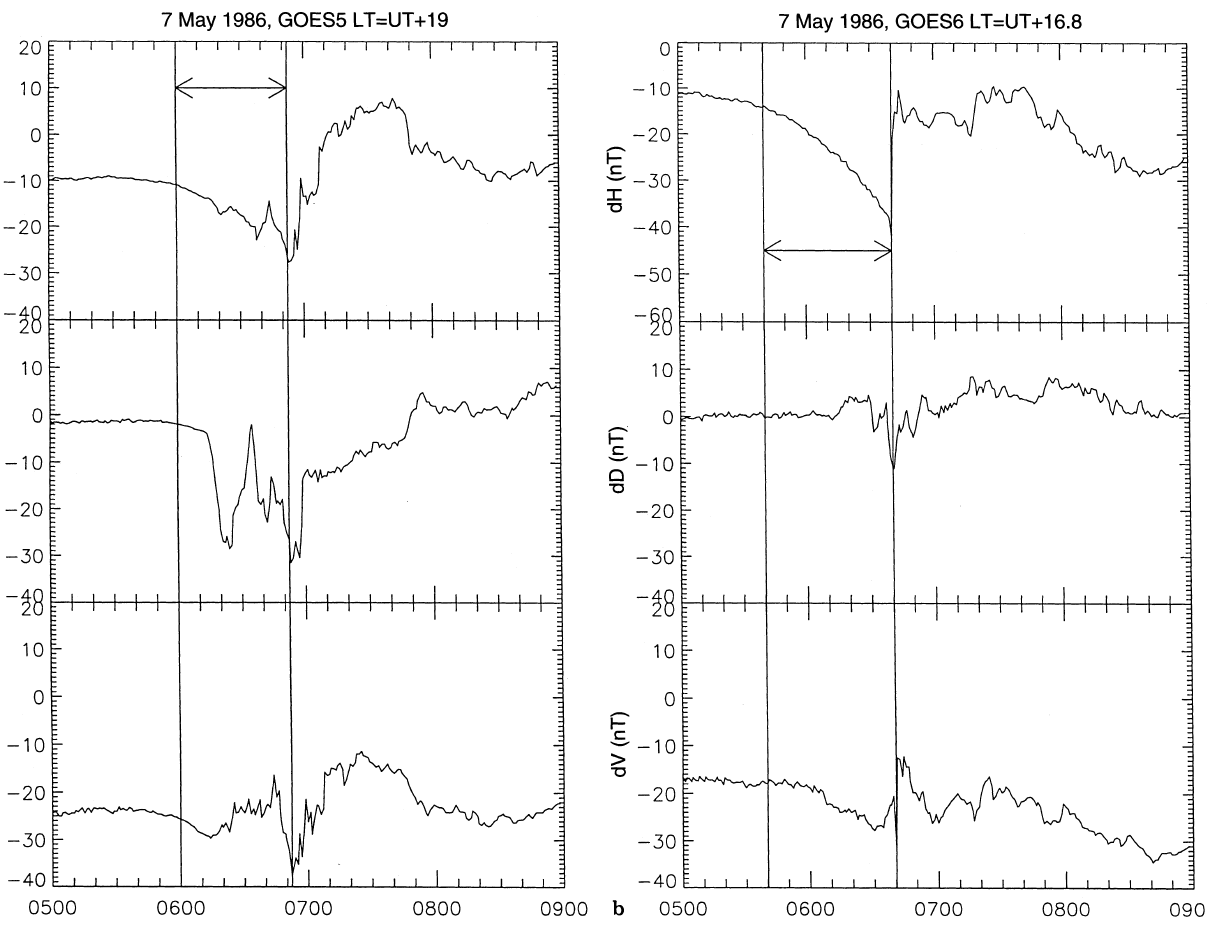
b Magnetic field disturbance data from GOES-6 in VDH coordinates on May 7, 1986. The interval between the two lines at 0540 UT and 0640 UT corresponds to the growth phase at GOES-6 position. At 0640 UT GOES-6 detects the dipolarization of